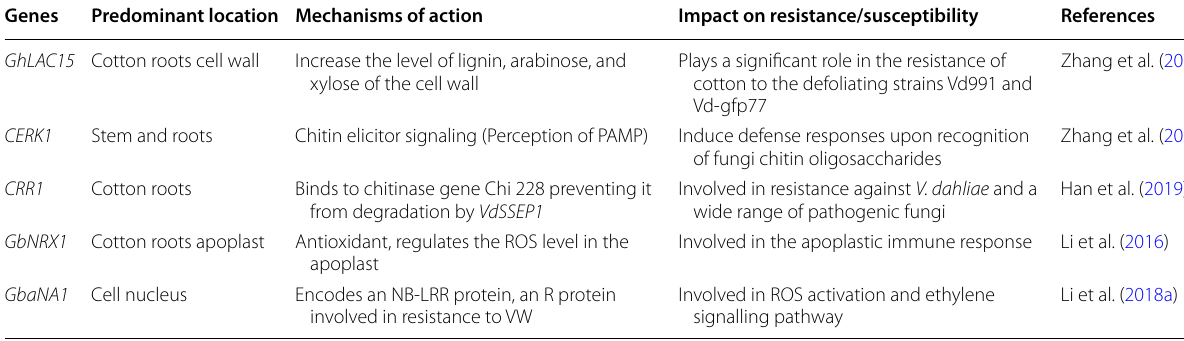
Table 1 Newly identified cotton genes playing a role in VW resistance Genes